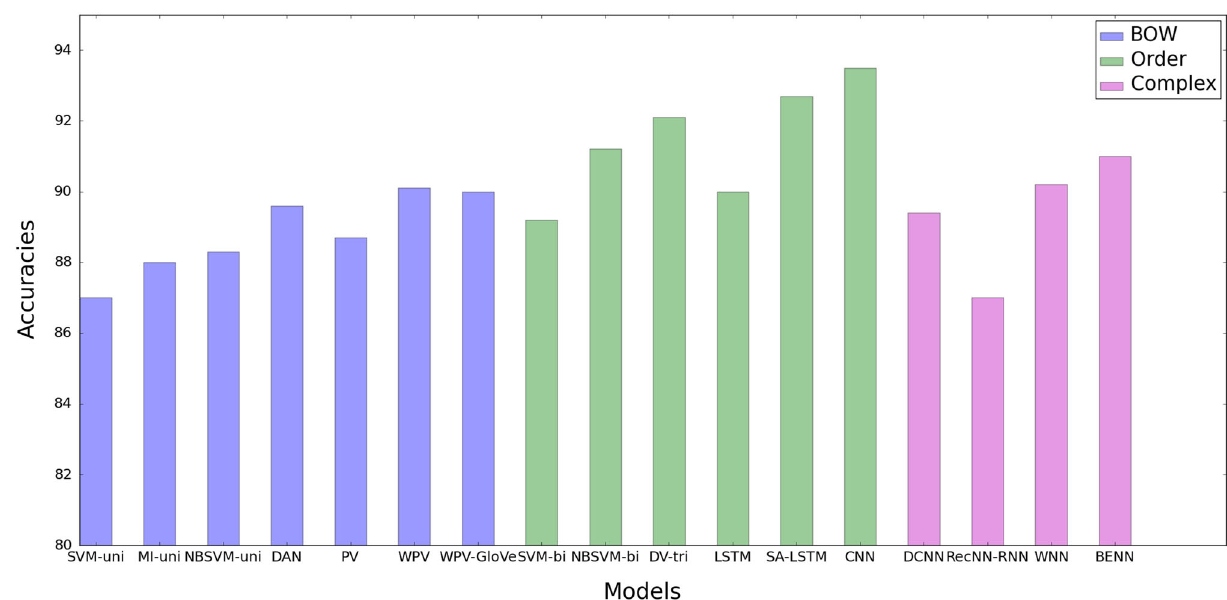
Fig. 5 Comparisons of our models with state of the arts. SVM-uni, NBSVM-uni, SVM-bi, and NBSVM-bi: [24]. MI-uni: [20]. DAN: [7]. PV: [18]. DV-tri: [14]. LSTM and SA-LSTM: [2], CNN: [8]. DCNN: [4]. RecNN-RNN, WNN, and BENN: